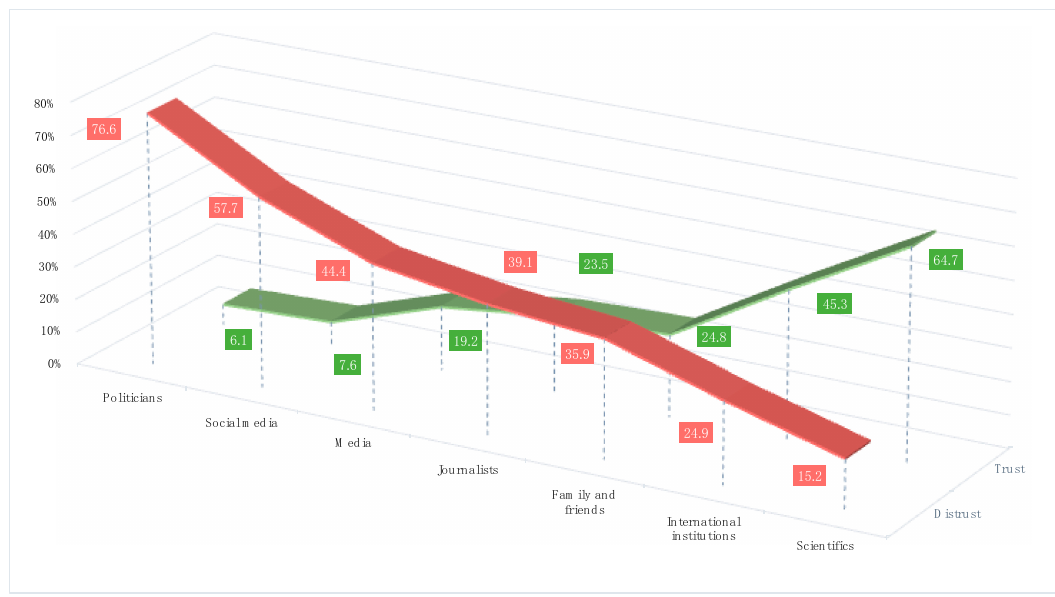
Figure 8. Percentages in trust and distrust feelings about social agents. Own elaboration.